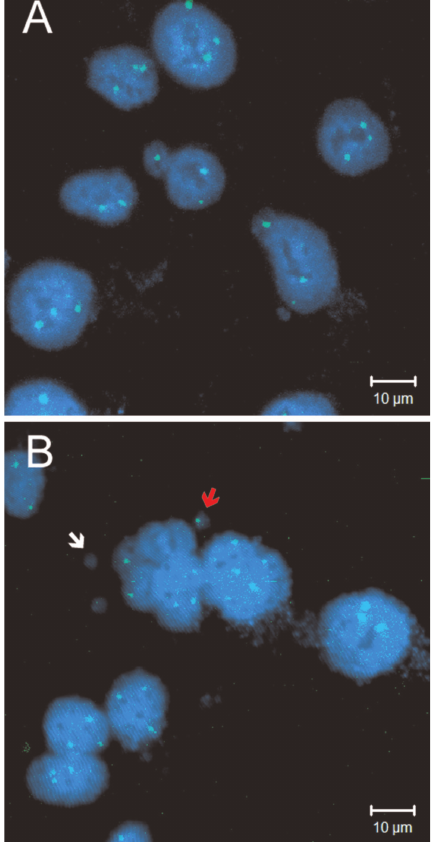
Figure 5. Fluorescent in situ hybridization of ErbB1 gene in A549 cells. A , Control cells (from non-synchronized cell culture) showing usually 3 copies of ErbB1 gene in each nucleus. B , Cells submitted to synchronization protocol after 18 h recovery. Note a micronuclei positive to ErbB1 labeling (red arrow) and micronuclei negative to ErbB1 labeling (white arrow). Multinucleated cells showed a deviation of the usual number of copies of ErbB1. The ErbB1 gene was labeled in green. Nuclei were counterstained with TO-PRO-3 (blue). Images were obtained by laser scanning confocal microscopy.